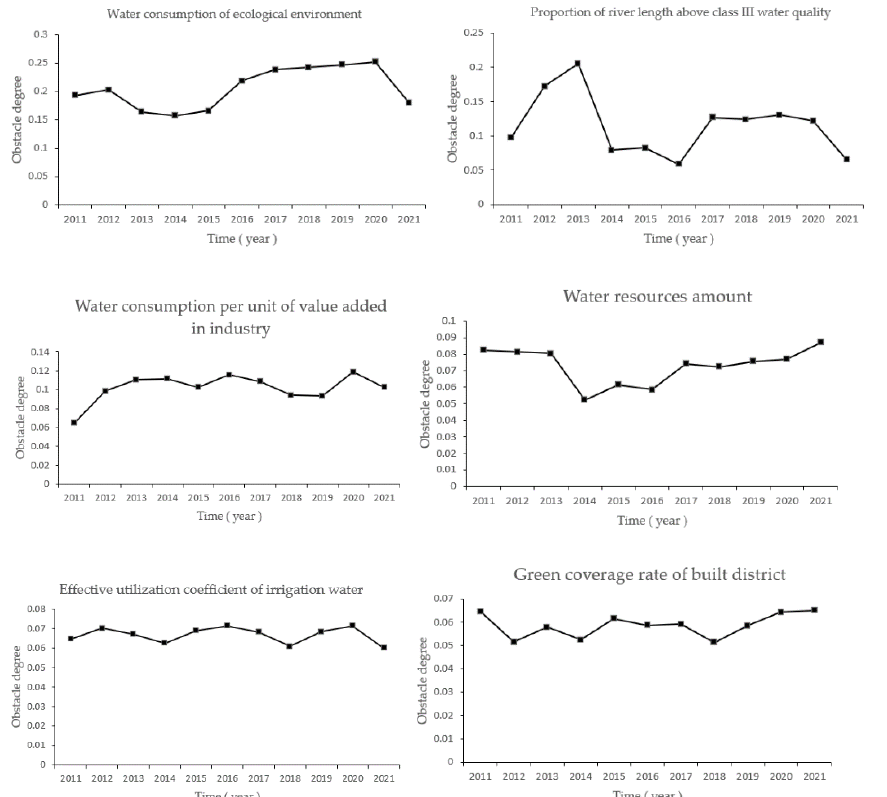
Figure 7. Obstacles of Main Indicators in Zhengzhou City, 2011–2021.